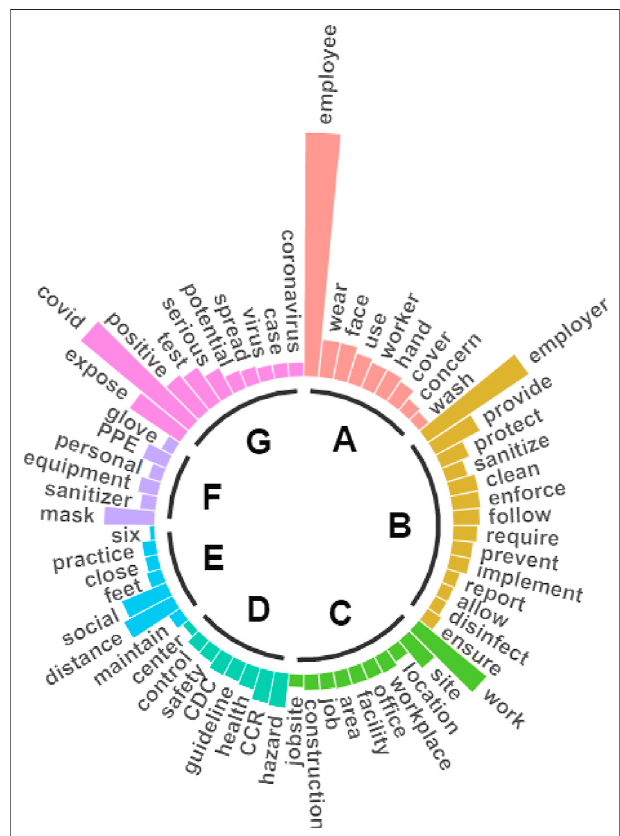
FIGURE 7 | Most frequent terms used in the complaints' description section and their categories – Figure generated with the R code provided by (Holtz,